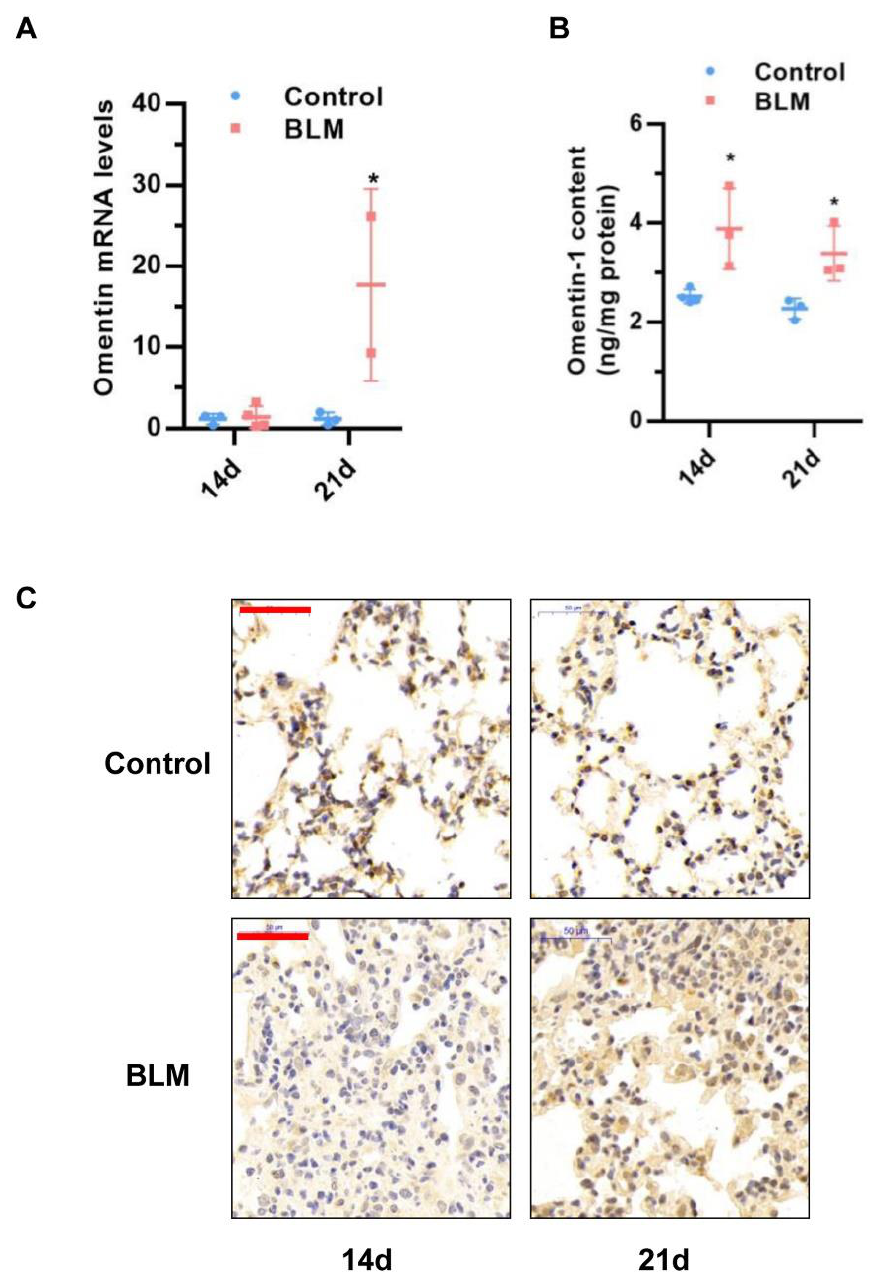
Figure 1. The expression level of omentin-1 in mouse lung tissue after Bleomycin (BLM) challenge for 14d and 21d. ( A ) The expression of omentin-1 mRNA in the lung tissue of mice detected by qPCR ( n = 3); ( B ) The content of omentin-1 protein in lung homogenate of mice detected by ELISA ( n = 4). ( C ) Immunohistochemical staining of lung sections for omentin-1 (Bar = 50 μm, n = 4). The data are presented as the mean ± SD. * p < 0.05 vs. control group.